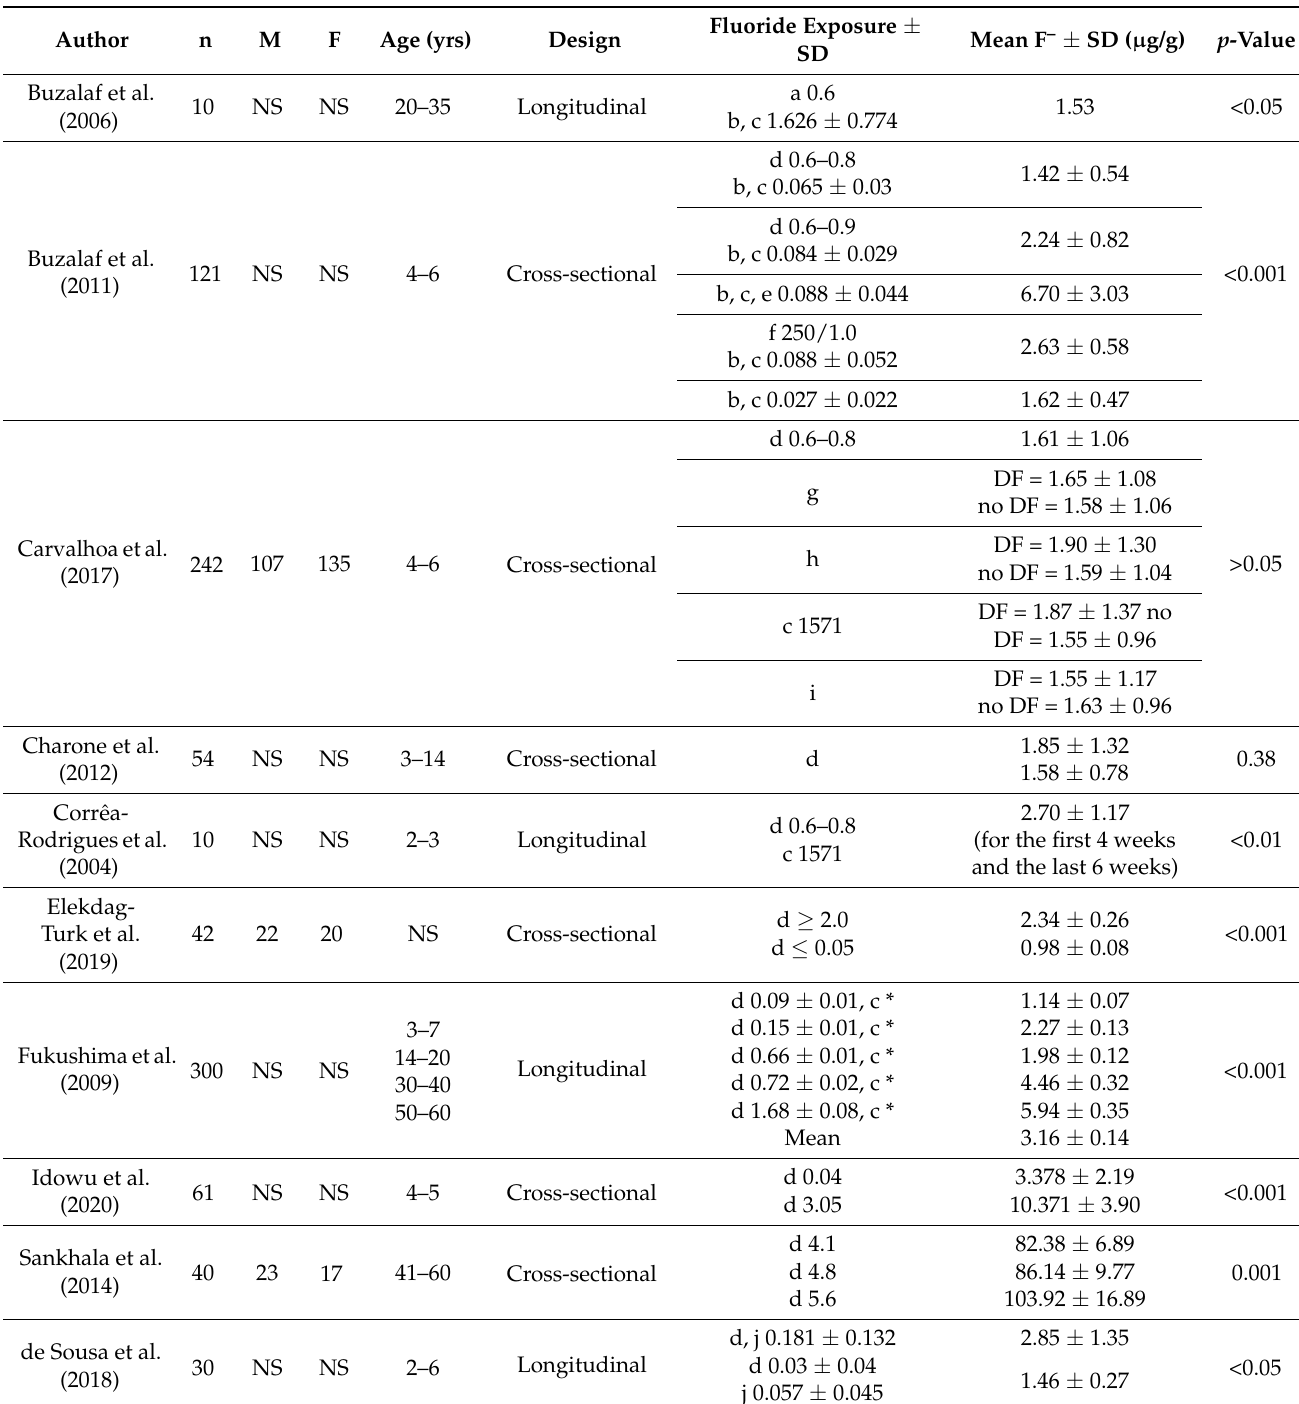
Table 2. Fluoride concentration in